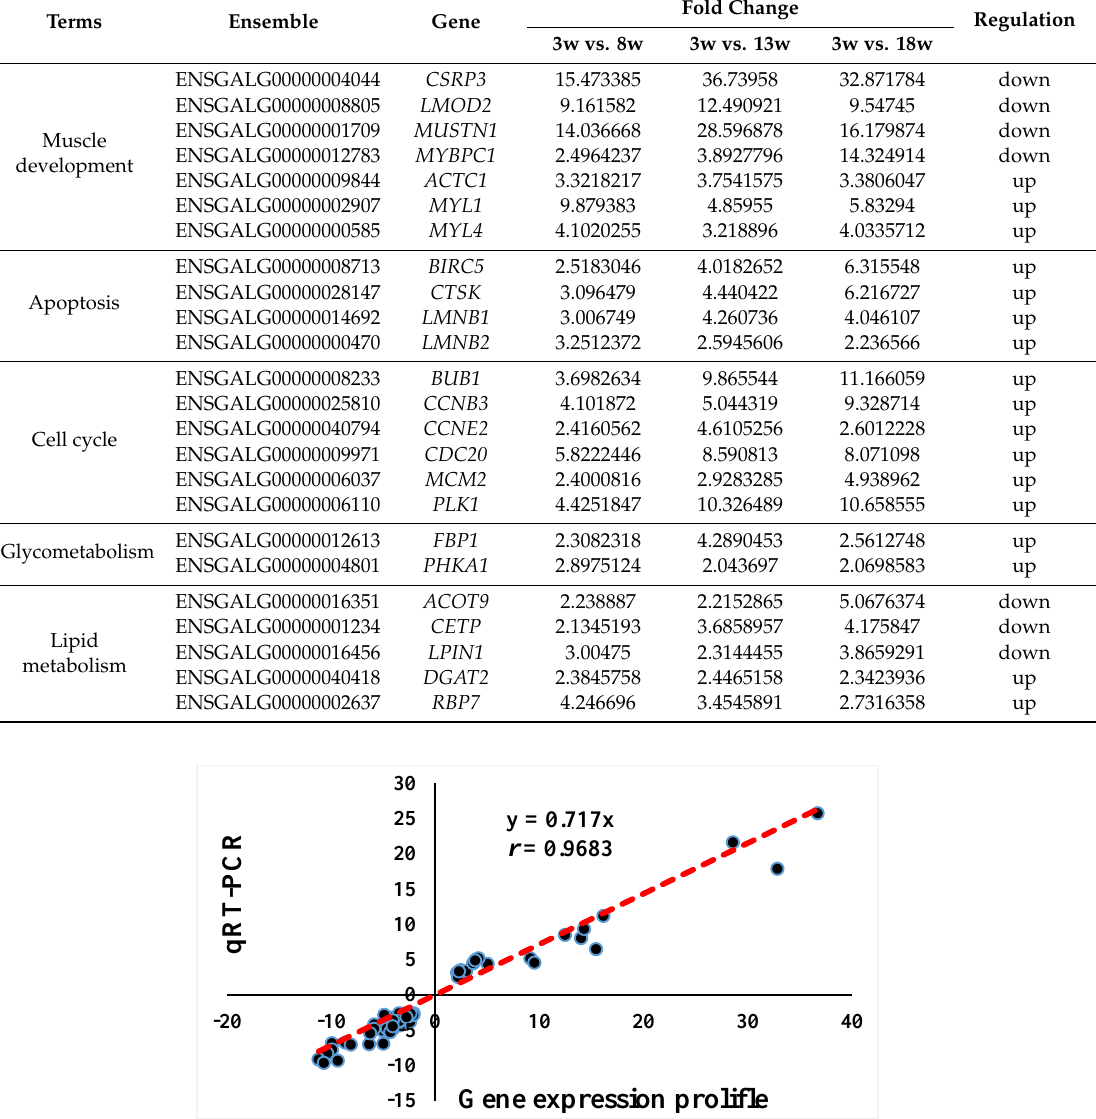
Table 4. The screened 24 DEGs related to muscle development, cell number, and energy metabolism from data of gene expression profiling.